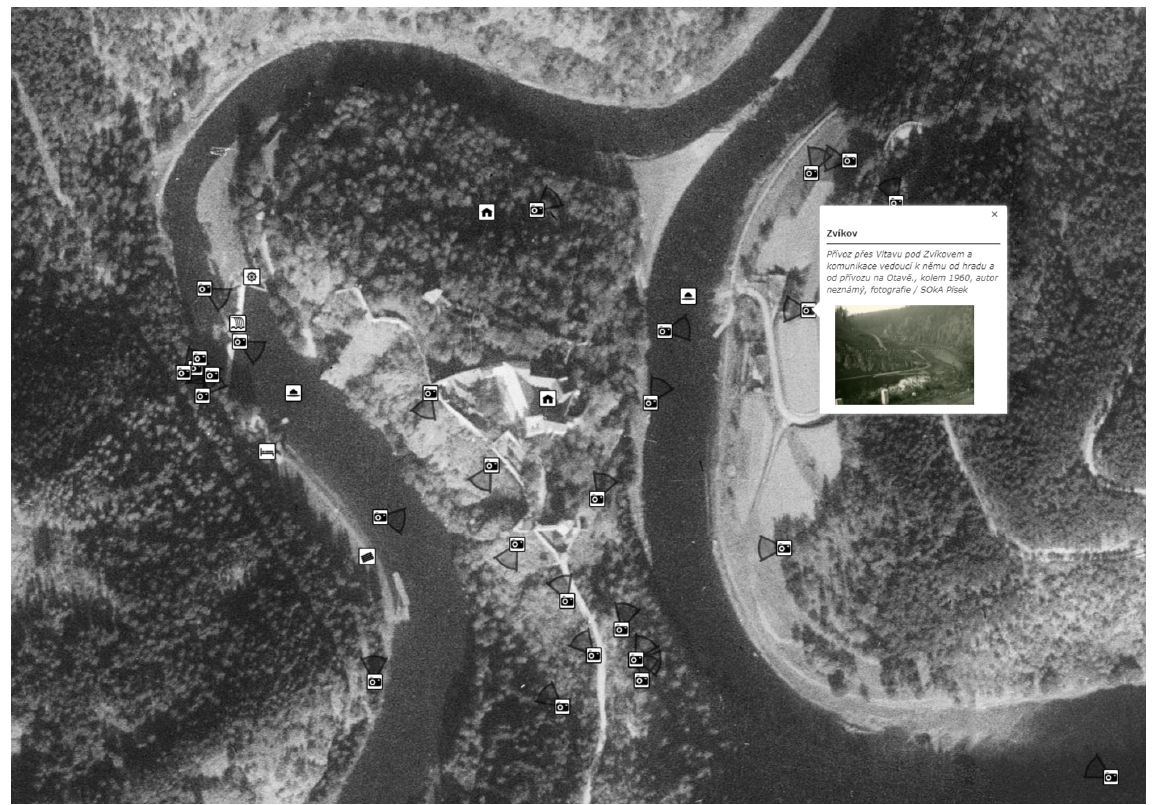
Figure 2. Visualized database of localized photographs and other places, Source: author’s elaboration.